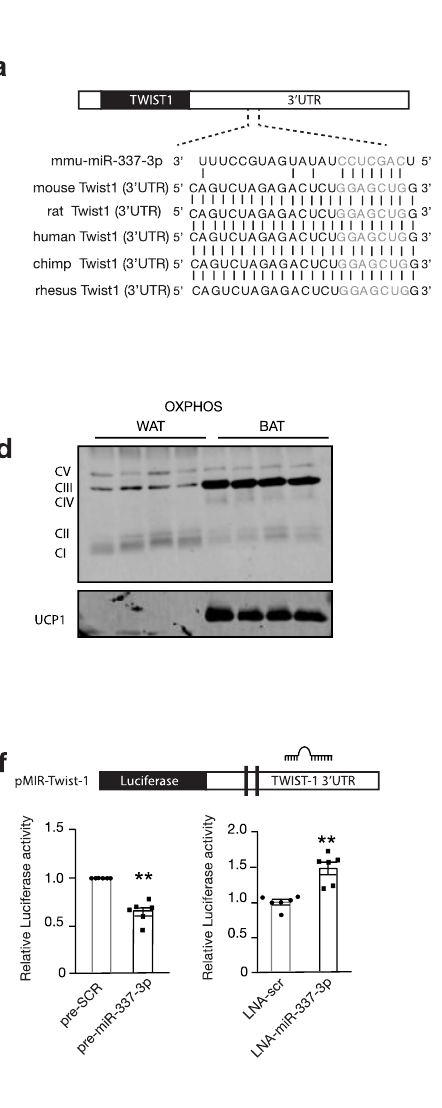
Figure 3. miR-337-3p targets Twist1. ( a ) Schematic representation of predicted seed complementarity between the seed sequence of mmu-miR-337-3p, and seed region on Twist1 3 (cid:48) UTR and the evolutionary conservation of this region among species. ( b ) RT-PCR and Western blot analysis of Twist1 mRNA expression normalized to 5S (WAT n = 5, BAT n = 4) and TWIST1 protein abundance (WAT n = 4, and BAT n = 5) in mouse WAT and BAT normalized to GAPDH. ( c ) Representative Western blot of TWIST1 and GAPDH housekeeping protein in mouse WAT and BAT quantified in ( b ). ( d ) Western blot of mitochondrial OXPHOS, Complex V, IV, III, II, and I and thermogenic UCP1 protein. ( e ) Quantification of ( d ) OXPHOS and UCP1 protein abundance in mouse WAT and BAT normalized to TPS as the loading control. ( f ) Schematic of luciferase reporter plasmid containing Twist’1 3 (cid:48) UTR with a binding site for miR-337-3p. Relative luciferase activity quantification in Cos7 cells containing reporter plasmids, co-transfected with either mmu-miR-337-3p precursor or scrambled precursor, and co-transfected with LNA inhibitor for miR-337-3p or LNA inhibitor negative control. Data are presented as means ± SEM, and individual data points are given by the dot plot * p < 0.05; ** p < 0.01, by Independent sample t -test, equal variances not assumed. *** p < 0.001, by Independent sample t -test, equal variances assumed. n, number of biological replicas; 3 (cid:48) UTR, 3 (cid:48) untranslated region; OXPHOS, oxidative phosphorylation; UCP1, uncoupling protein-1; GAPDH, Glyceraldehyde 3-phosphate dehydrogenase; Twist1 , twist-related protein; RT-PCR, quantitative real-time polymerase chain reaction; TPS, total protein